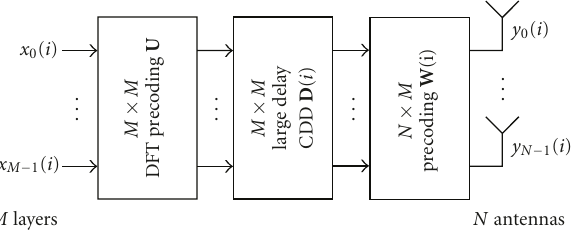
Figure 2: Open-loop spatial multiplexing with N antennas and M